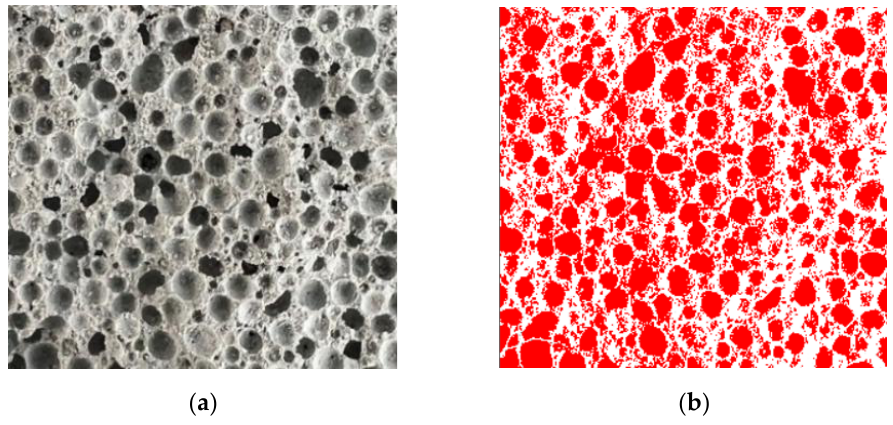
Figure 2. Typical initial image and processed image of the foamed concrete: ( a ) 10 mm × 10 mm section; ( b ) processed image 10 mm × 10 mm section.